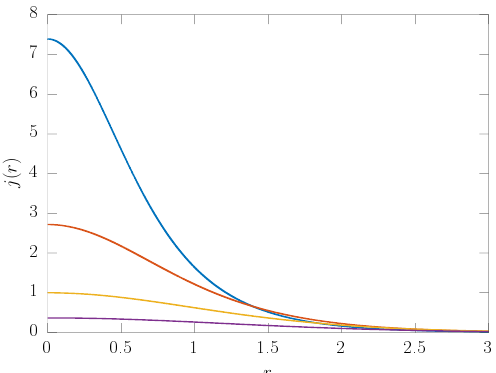
Figure 3. Solutions of Equation (12) with the plus sign. All profile are monotonous and decrease quite fast and the fixed point j = 0 is an attractor. Initial conditions are φ ( 0 ) = 2 (blue), φ ( 0 ) = 1 (orange), φ ( 0 ) = 0 (yellow) and φ ( 0 ) = 1 −